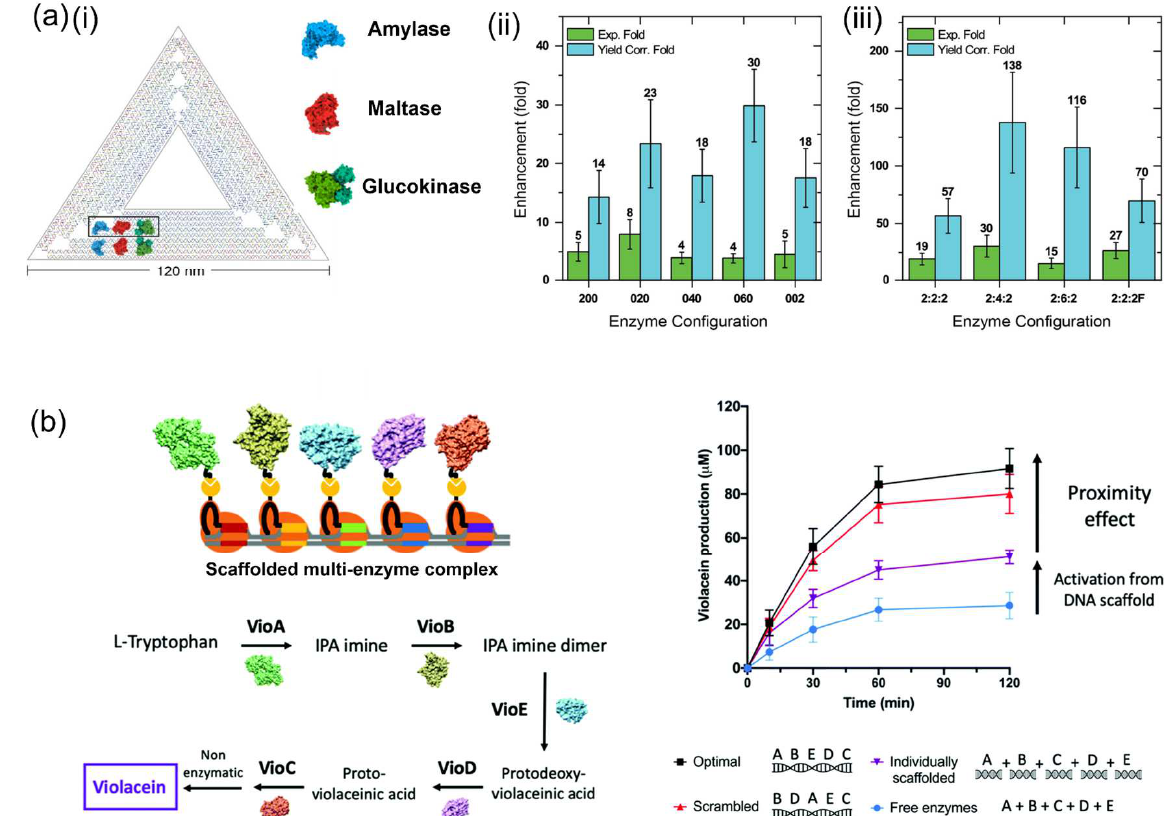
Figure 9. Activation of enzyme cascade reactions on the DNA scaffold. ( a ) Amylase, maltase and glucokinase co-assembled glucokinase co-assembled on a triangular DNA scaffold. ( i ) A scheme presenting the co-assembly of on a triangular DNA scaffold. ( i ) A scheme presenting the co-assembly of amylase, maltase and glucokinase on the DNA amylase, maltase and glucokinase on the DNA scaffold. ( ii ) Fold enhancement for the individual scaffold. ( ii ) Fold enhancement for the individual enzyme configurations. The green bars represent the experimentally enzyme configurations. The green bars represent the experimentally determined enhancements determined enhancements (Exp. Fold). The blue bars represent the theoretical max enhancement obtainable assuming 100% attachment yield (Yield Corr. Fold). ( iii ) Fold enhancements for the full enzyme cascade configurations [88]. ( b ) Scheme of the CRISPR/Cas-directed programmable assembly of five enzymes on a DNA scaffold to convert L-tryptophan into violacein [89]. Reprinted with permission from: ( a ) Ref. [88]. Copyright 2019 American Chemical Society; ( b ) Ref. [89].